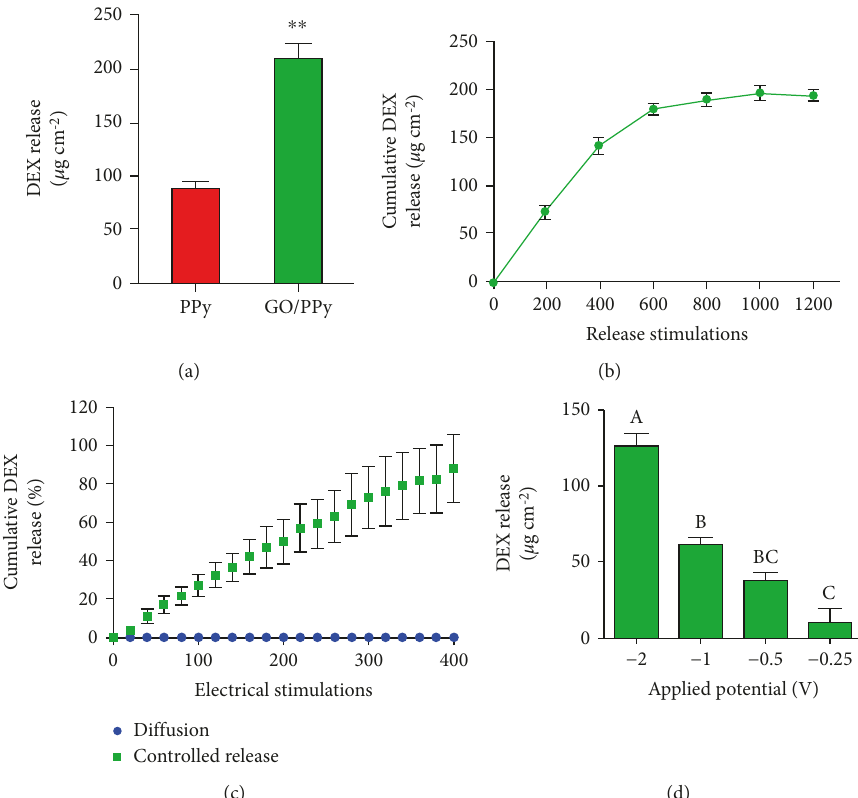
Figure 4: Electrically controlled DEX release from the GO/PPy nanocomposite fi lm. (a) Total DEX release from PPy fi lms with or without GO as a codopant in response to an aggressive square-wave, biphasic voltage stimulation (-2.0 V for 5 s, followed by 0 V for 5 s) repeated for 1000 stimulations. The GO/PPy-DEX nanocomposite released a signi fi cantly larger quantity of DEX ( p < 0 01 ; n = 3 ). (b) Cumulative release pro fi le of the GO/PPy-DEX nanocomposite in response to aggressive repeated square-wave, biphasic voltage stimulation (-2.0 V for 5s, followed by 0V for 5s) for 1200 stimulations ( n = 6 ). The release pro fi le reaches a plateau at 600-voltage pulses under this aggressive stimulation paradigm, indicating that all available drugs have been released at this point. (c) Cumulative release pro fi le of the GO/PPy-DEX nanocomposite in response to milder release stimulation (-0.5 V for 5s, followed by 0.5V for 5s) and in the absence of electrical stimulation (passive di ff usion) ( n = 3 ). Electrical stimulation elicited a linear release for up to 400 pulses, while no drug passively di ff used from the fi lm when no voltage stimulation was applied. (d) E ff ect of voltage stimulus modulation on the amount of DEX released from nanocomposite fi lms. GO/PPy-DEX nanocomposite fi lms were submitted to 100 square-wave, biphasic stimulation pulses where the negative phase was varied from -2 to -0.25V, the positive phase was 0.5V, and the stimulus lingered at each phase for 5s. Bars labeled with nonmatching letters indicate a signi fi cant di ff erence between groups ( p < 0 01 , n = 3 )